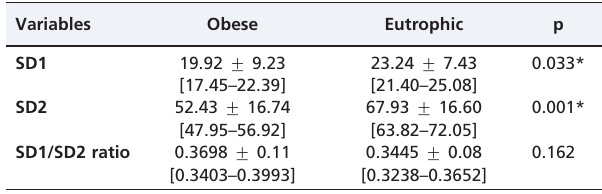
Table 4 - Mean, standard deviation, 95% confidence interval and p value for Poincare´ plot of obese and eutrophic children.